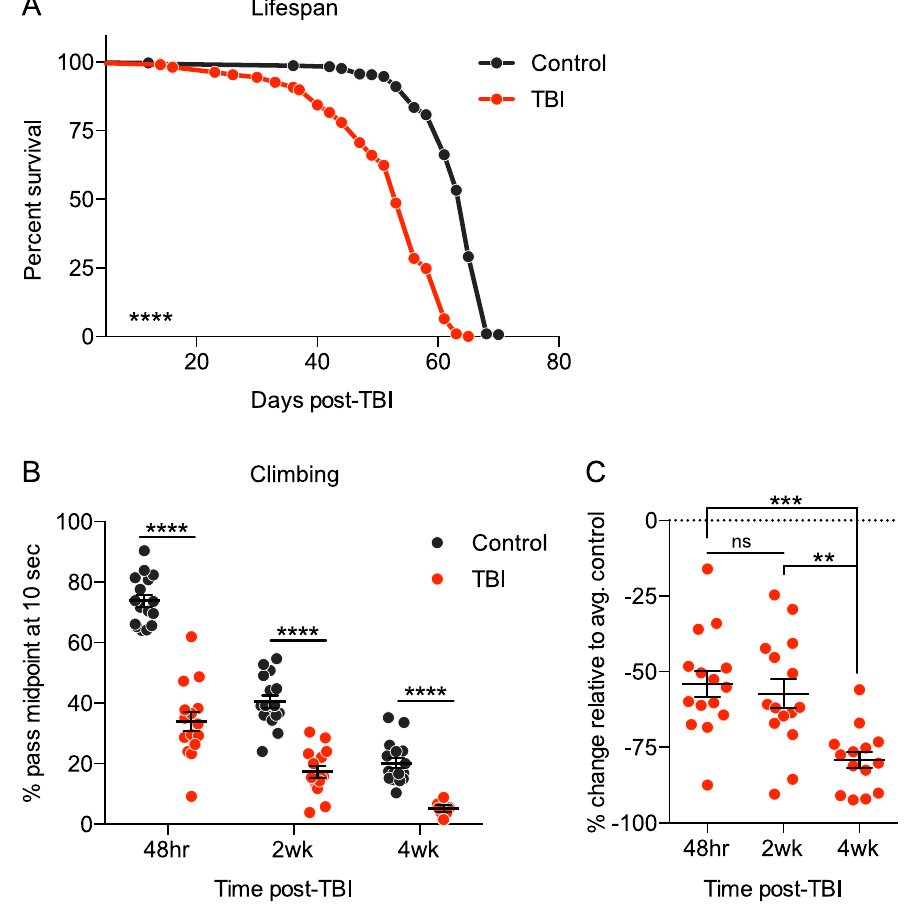
Figure 1. Traumatic Brain Injury (TBI) induces long-term physiological neurodegenerative phenotypes. TBI- treated flies = red; age-matched, uninjured control flies = dark grey. ( A ) TBI-treated flies exhibit significantly decreased lifespan, as previously reported 37,41 . Acute death in the first 48 h following injury is excluded. One of three independent repeat lifespan experiments is shown (sample size of 110–300 flies per condition). p < 0.0001 according to both Log-rank and Gehan-Breslow-Wilcoxon survival comparison tests. ( B ) TBI-treated flies exhibit significantly decreased climbing ability at multiple timepoints following the injury: 48 h, 2 weeks, and 4 weeks. Climbing ability is determined as the percent of flies past the midpoint of the climbing vial after 10 s of climbing (at least 14 groups of 20–25 flies each). TBI compared to control at each timepoint is p < 0.0001 according to two-way ANOVA, with Sidak’s multiple comparison correction. One outlier was identified and removed from 4 weeks TBI dataset according to ROUT method (Q = 1%). ( C ) TBI-treated flies display a larger decrease in climbing ability at 4 weeks post-TBI, calculated as percent change relative to average of age-matched, uninjured controls, than at 48 h and 2 weeks post-TBI. 48 h compared to 4 weeks: p < 0.001, 2 weeks compared to 4 weeks: p < 0.01; 48 h compared to 2 weeks: ns, according to a one-way ANOVA, with Tukey’s multiple comparisons